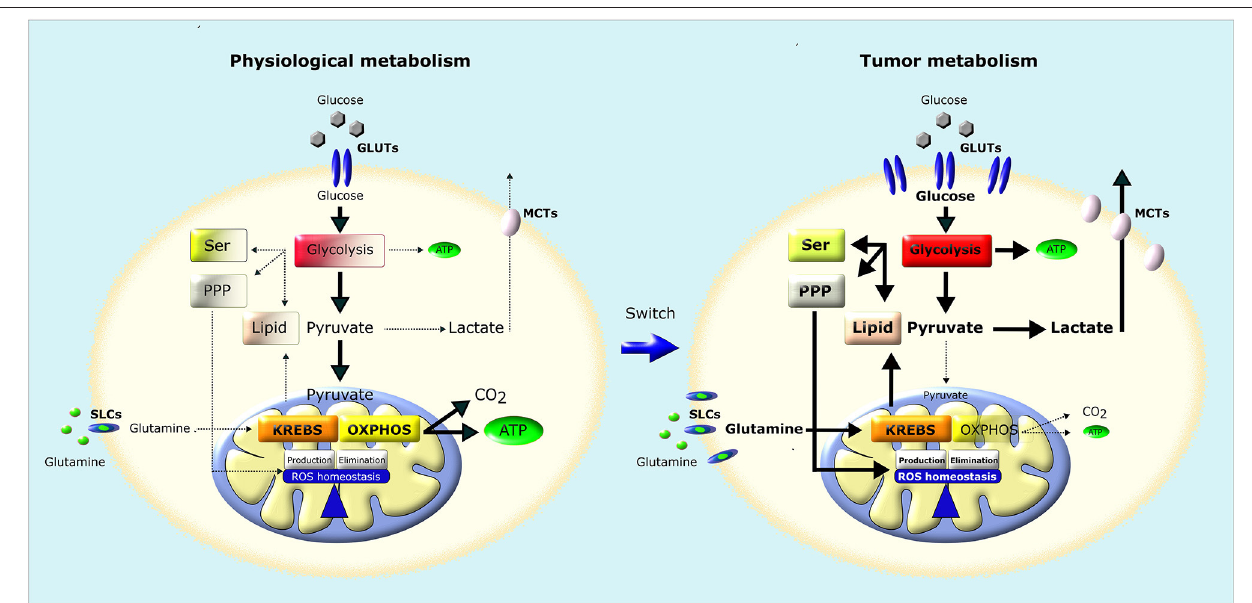
FIGURE 2 | Metabolic remodeling of cancer cells. In normal cells (left) , a large fraction of glucose is metabolized to pyruvate that is almost completely oxidized to CO 2 through TCA (Krebs) cycle and OXPHOS in mitochondria, producing a large amount of ATP. Pyruvate is metabolized to lactate only in conditions of limiting O 2 . Instead, most cancer cells (right) convert most glucose to lactate regardless of O 2 availability (Warburg effect). The increased glucose utilization through glycolysis, associated to an increase in glutamine utilization, generates metabolic intermediates used for the synthesis of nucleic acids through pentose phosphate pathway (PPP), serine biosynthesis pathway (SER) and lipid biosynthesis, providing the building blocks for the anabolic needs of cancer cells. In addition, neoplastic cells undergo an increase in ROS generation, and therefore increase their antioxidant defenses to avoid oxidative damage and maintain ROS homeostasis. GLUTs, Glucose Transporters; MCTs, Lactate Transporters; SLCs, Solute